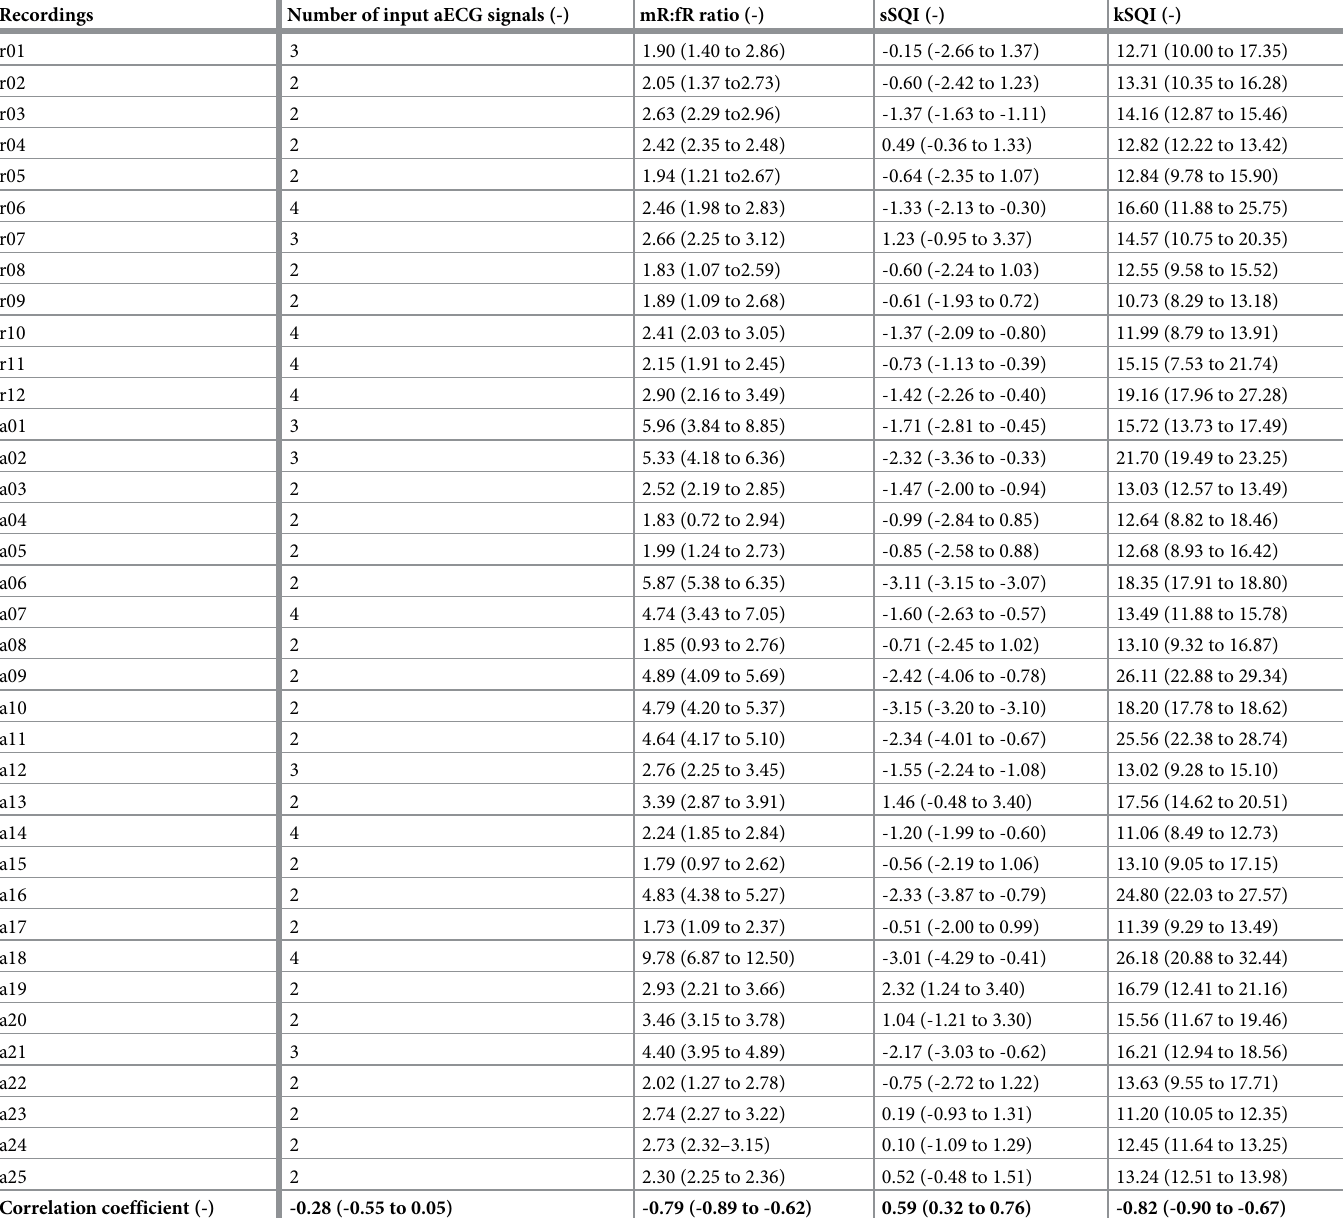
Table 10. Analysis of the influence of four factors (number of input aECG signals, average ratio between mR and fR oscillations, average value of sSQI and kSQI ) on the resulting extraction quality. The influence of each factor on the accuracy was evaluated using a correlation coefficient (the 95% confidence interval is reported in